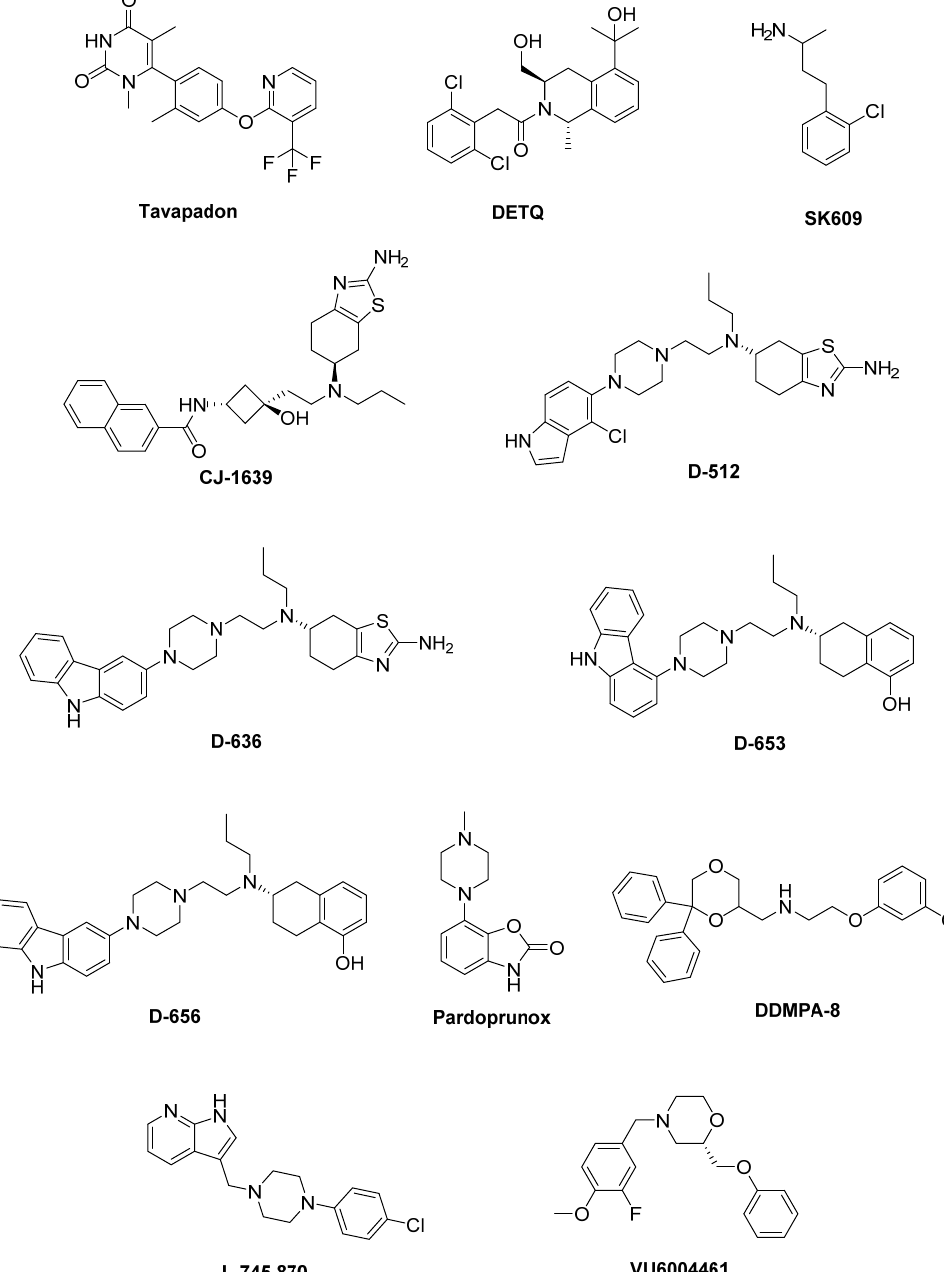
Figure 2. Emerging dopaminergic ligands as new levodopa (LD) adjuvant candidates.